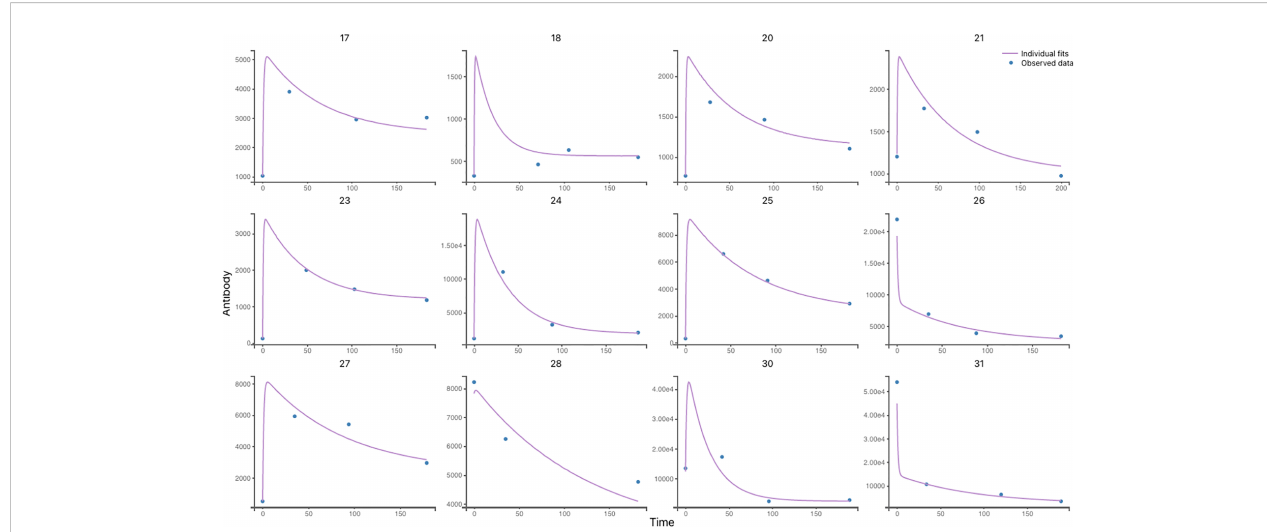
FIGURE 4 Individual antibody response to VZV Reactivation in 12 participants using Model 6. Individual predictions using individual parameters and individual variables with respect to time on a continuous grid with observed VZV antibody data overlaid are displayed in this graphic. (more details about other participants are shown in Figure 9).